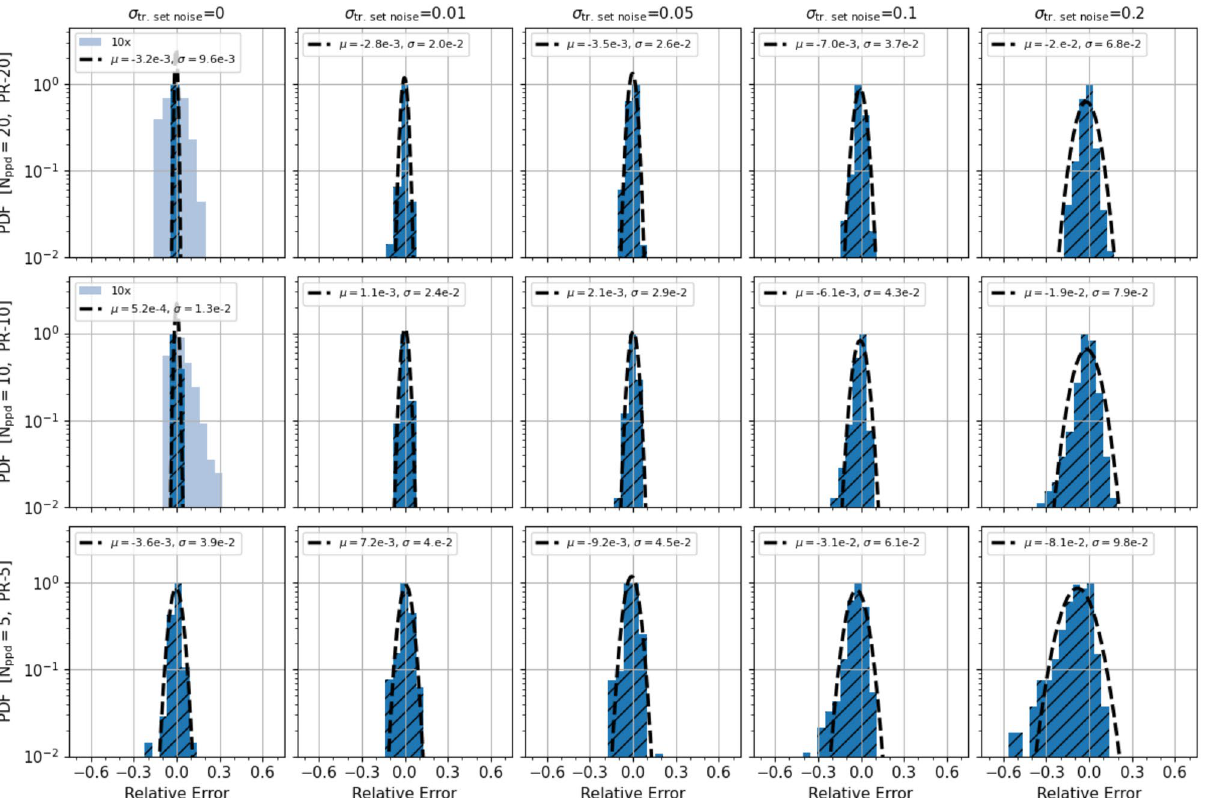
Figure 6. MLP models test errors: Histogram of the test-errors of the MLP models in Table 3. All the histograms are rescaled so that they all peak at 1. Each row corresponds to a different N ppd (and parameter range domain PR- N ppd ), while each column corresponds to a different value of σ n , the noise in the flux dataset before applying Tikhonov’s regularization. The errors are computed with respect to the noiseless testsets, i.e. the A.0, B.0 and C.0 testsets for models of the A-, B-, C-series, respectively. The legend shows the mean µ and standard deviation σ of the histogram in each panel. The lightblue shapes in some panels correspond to a histogram of 10 larger ×